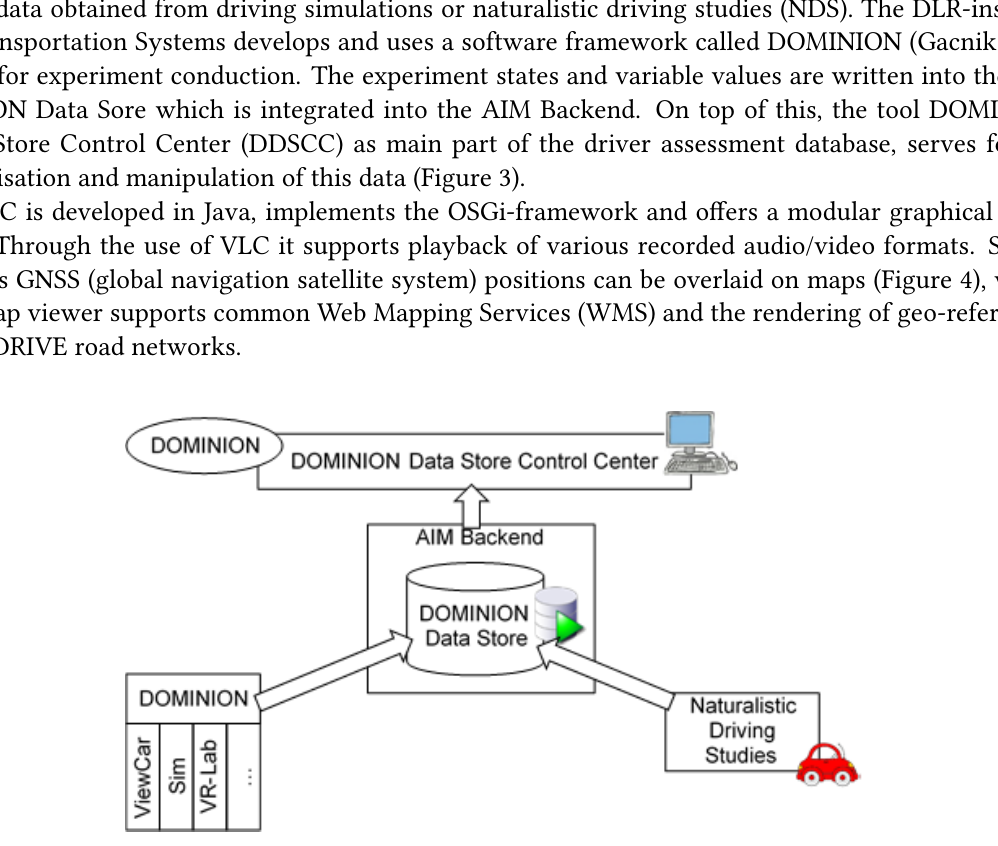
Figure 3: Dominion Data Store Control Center.